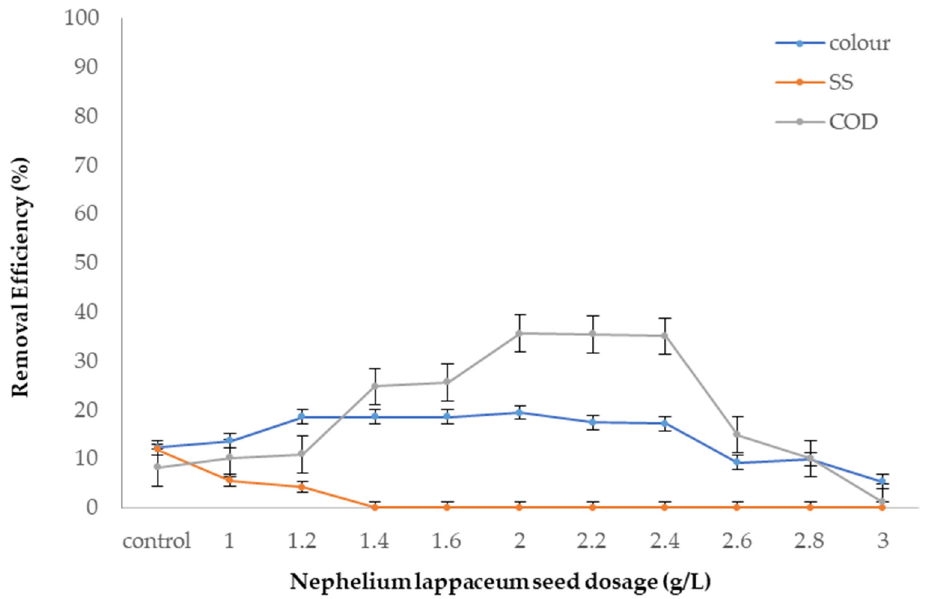
Figure 8. SS, colour, and COD removal efficiency with different dosages of Nephelium lappaceum seed at pH 6. Table 4. Comparison of optimum dosage of Nephelium lappaceum with other natural coagulants from previous